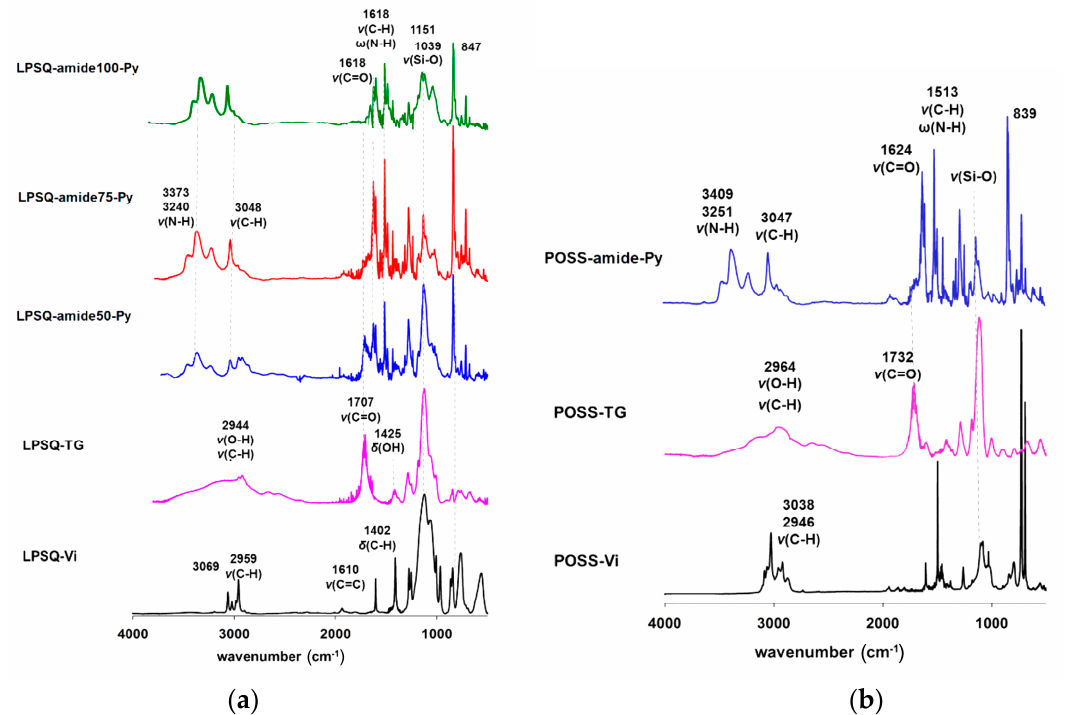
Figure 1. FTIR spectra plotted in absorbance mode (arbitrary units ) of ( a ) LPSQ-triazole-Py and ( b ) POSS-triazole-Py along with spectra of the intermediate products.